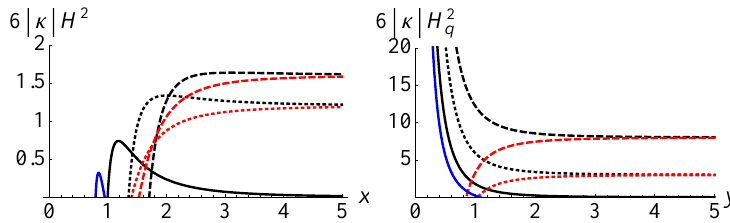
Figure 2. The squared Hubble rate of the physical metric ( left ) and the auxiliary metric ( right ) are shown as functions of the rescaled scale factors x and y , respectively. In these figures, we choose a negative κ . The black and red curves correspond to l = − 1 and l = 1, respectively. Within the black and red curves, the solid, dashed, and dotted curves correspond to λ = 1, λ = 1/5, and λ = 2/5, respectively. Besides, the blue curves exhibit the solutions in which the universe has a smooth bounce between an expanding phase and a contracting phase ( λ = 2, l = −